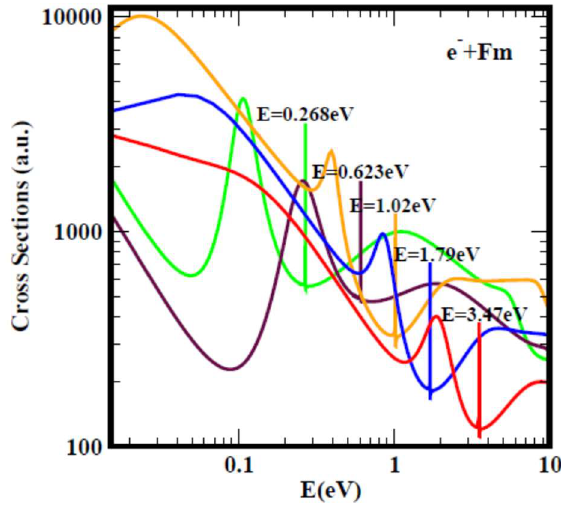
Figure 1. Total cross sections (a.u.) for electron elastic scattering from atomic Bk ( left panel ) and Cf ( right panel ) are contrasted. For both Bk and Cf the red, blue, and orange curves represent TCSs for the ground and the two metastable states, respectively, while the brown and the green curves correspond to excited state TCSs. The dramatically sharp resonances in the TCSs of both figures correspond to the Bk − and Cf − negative ions formed during the collisions. Importantly, the flip over of the near-threshold R-T minimum from the Bk TCSs to an SR very close to threshold in the Cf TCSs occurs here.